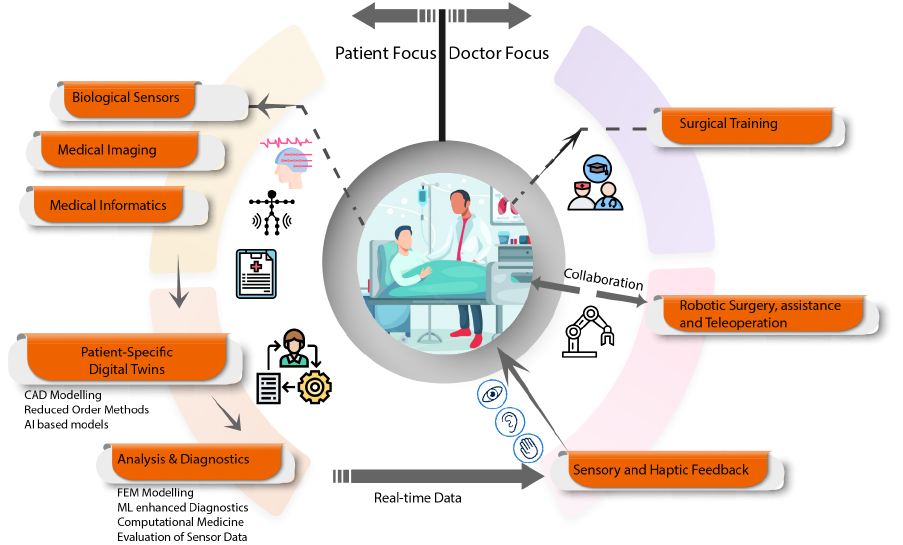
Figure 12. Generic framework for DTs in healthcare.